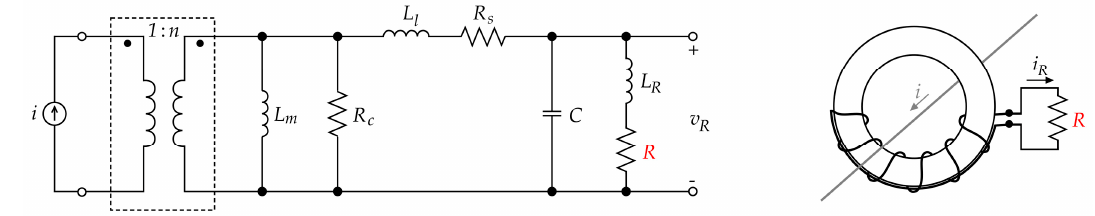
Figure 12. High-frequency current transformer model with parasitic components.